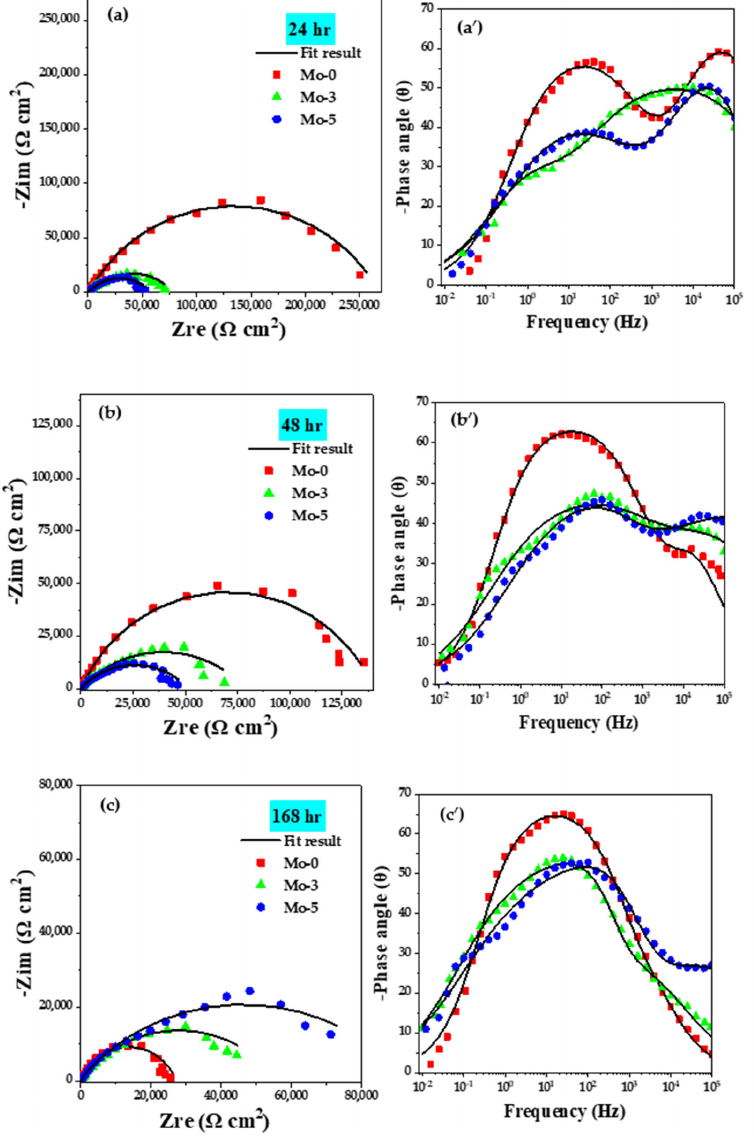
Figure 8. Nyquist and Bode-phase plots of the coated samples after long-term exposure to 3.5 wt.% NaCl solution for: ( a,a ′ ) Mo – 0, ( b,b ′ ) Mo – 3, and ( c,c ′ ) Mo – 5.